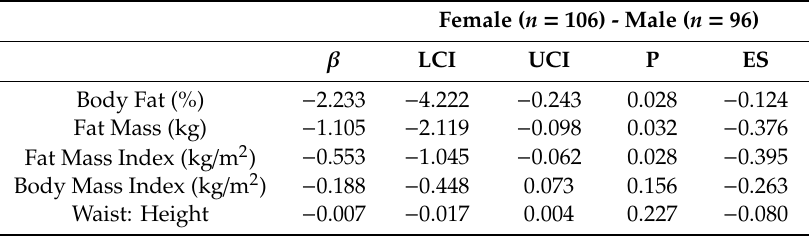
Table 5. Linear associations between body composition measures and breakfast foods in PROP non-tasters: sex interaction e ff